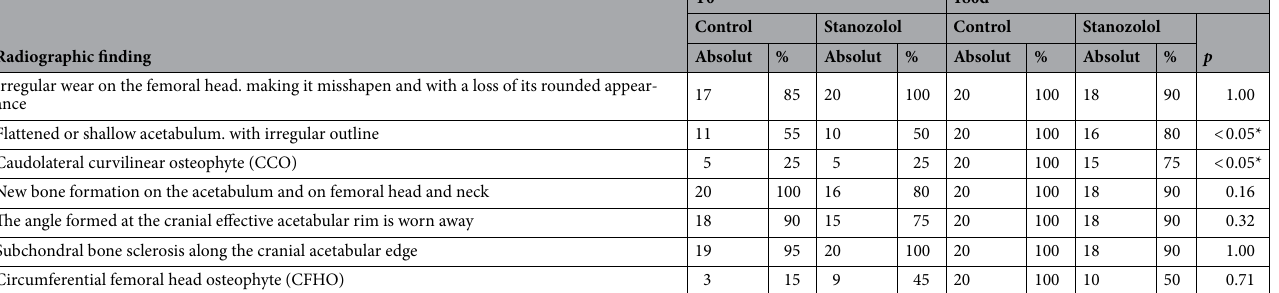
Table 3. Frequency of radiographic findings within the Control and Treatment Groups, at the initial and final evaluations. *Indicates significance.